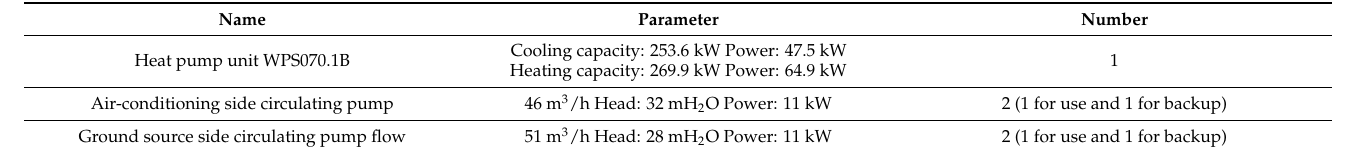
Table 2. Cold and heat sources of typical expressway service buildings.